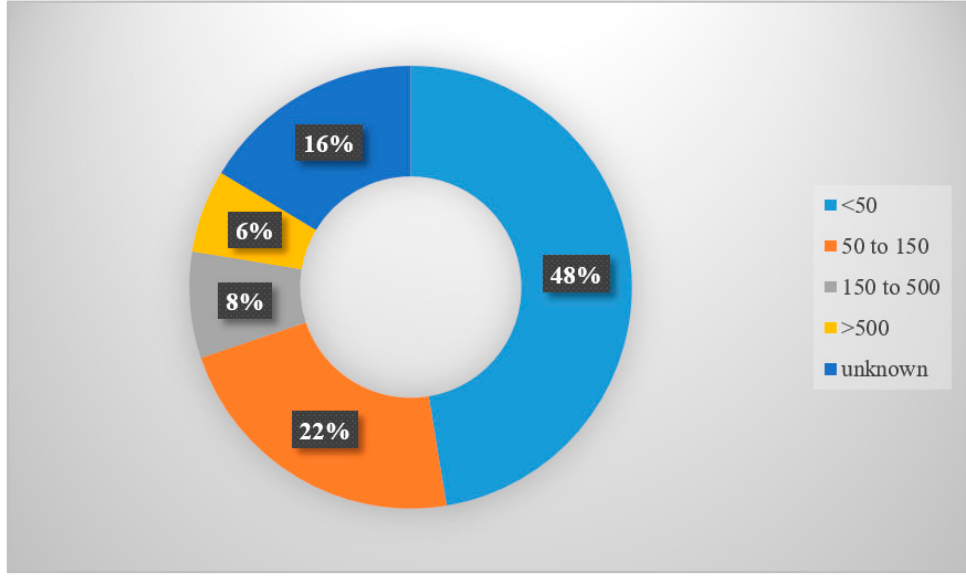
Aerospace 2020 , 7 , x FOR PEER REVIEW Figure 3. Constellations by satellite numbers. Figure 3. Constellations by satellite numbers.